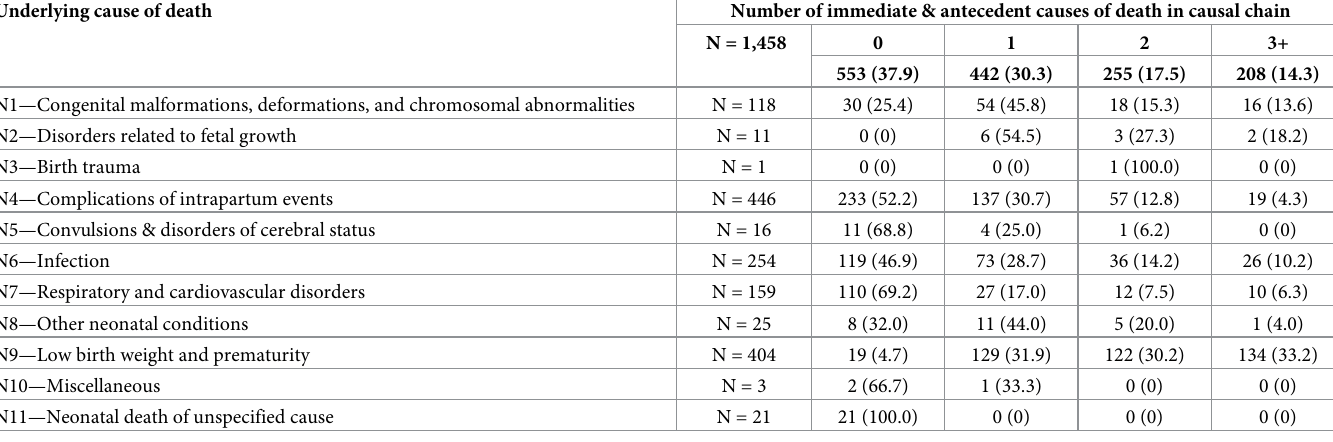
Table 4. Number of immediate and antecedent conditions in the causal chain for CHAMPS deaths that occurred in the neonatal period, by each WHO ICD 10 PM underlying cause of the death (2016–2021). Underlying cause of